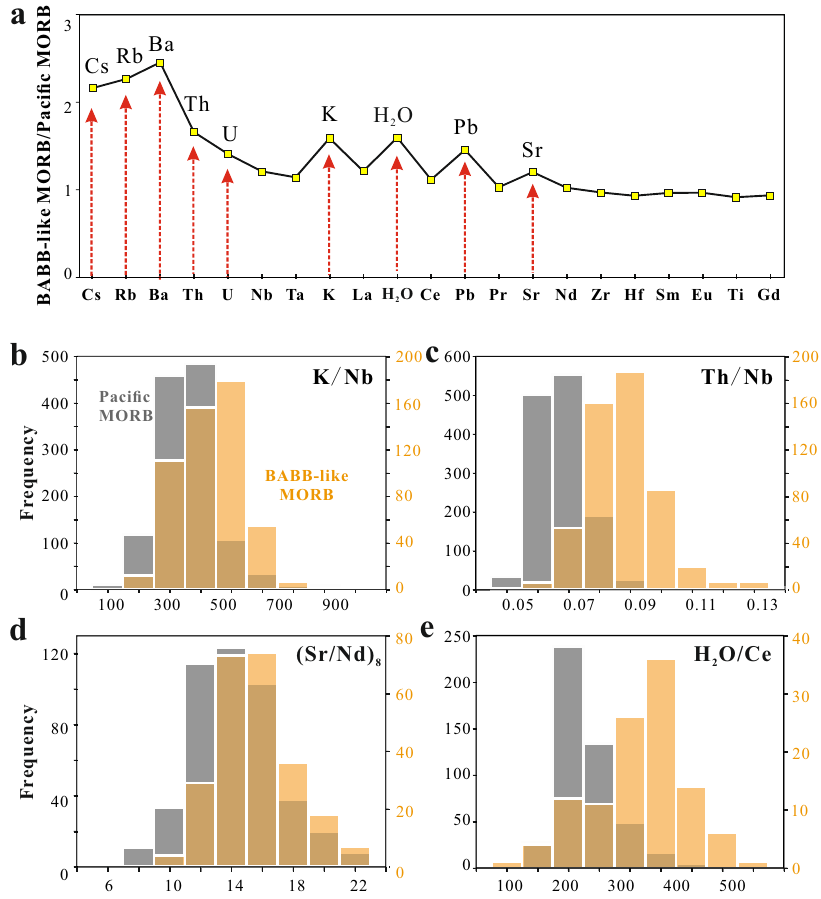
Fig. 5 Chemical variations of mid-ocean ridge basalts with back-arc signatures relative to Paci fi c mid-ocean ridge basalts. a Enrichment factors of average mid-ocean ridge basalts with back-arc signatures (BABB-like MORB) relative to average Paci fi c MORB. BABB-like MORB are enriched in Cs, Rb, Ba, Th, U, K, H 2 O, Pb, and Sr relative to Paci fi c MORB (shown by the red dashed arrows). Log-normal mean values were calculated as the averages for both groups to approximate the median value of each dataset and are less in fl uenced by the few high concentrations 15 . The average Paci fi c MORB compositions were calculated using Paci fi c MORB with MgO >4 wt.%, so that the averages of the two groups have comparable MgO to minimize the effect of variable magma differentiation on the calculated results. b – e Histograms of K/Nb, Th/Nb, (Sr/Nd) 8 , and H 2 O/Ce for Paci fi c MORB and BABB-like MORB. BABB-like MORB are signi fi cantly different in all these ratios relative to Paci fi c MORB determined by Student ’ s t test ( P < 0.001). (Sr/Nd) 8 ratios are the Sr/Nd ratios of MORB with MgO between 7.5 and 8.5 wt.% to exclude the effect of varied degree of plagioclase crystallization on Sr variations. Darker brown shades are where the separate distributions for Paci fi c MORB (gray columns) and BABB-like MORB (brown columns corresponding to the y -axis to the right of each fi gure)